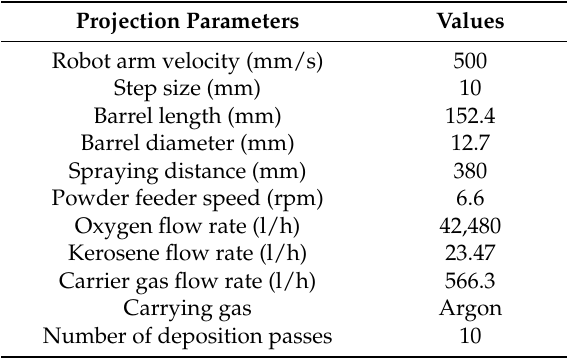
Table 1. High-Velocity Oxy-Fuel (HVOF) projection